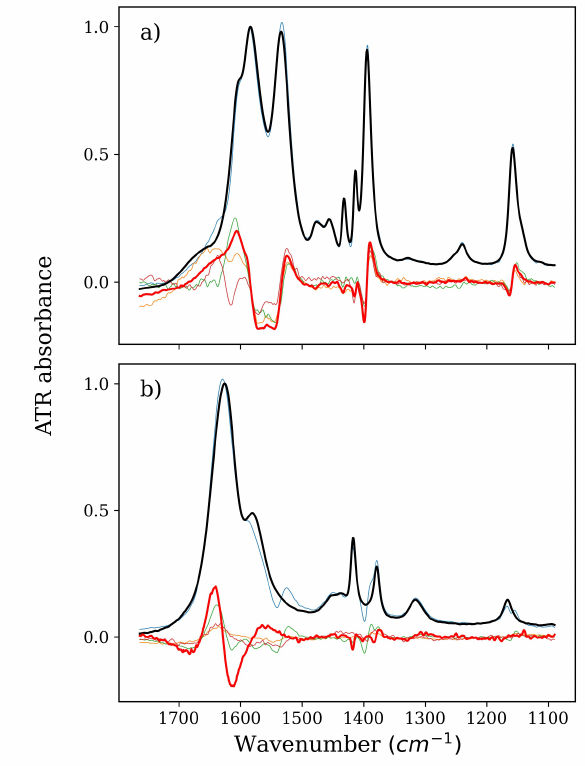
Figure 5. Spectra of pure TMU or NMA solution (thick black lines), derivatives (thick red lines), and isolated spectra of factors from a series devoid of ( a ) water and NMA or ( b ) water and TMU (all other thin lines). Part ( a ), therefore, denotes TMU, and Part ( b ) denotes NMA, both corresponding to the green and magenta series in Figure 6b,